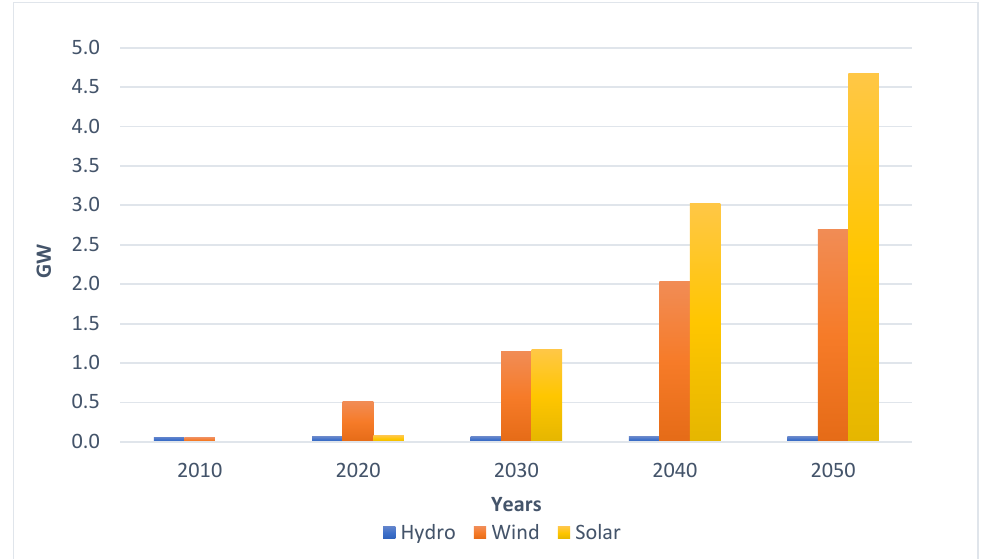
Figure 5. Renewable technology capacity (GW), over 2010 – 2050 in Tunisia (BAU scenario). Source: MENA-EDS Model [25].